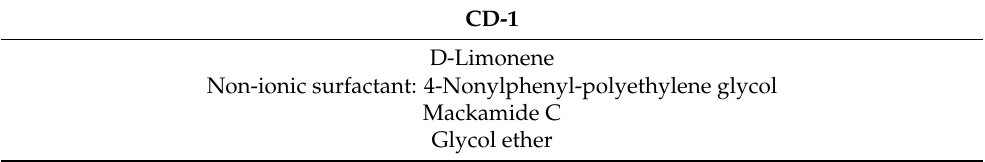
Table 3. Ingredients of